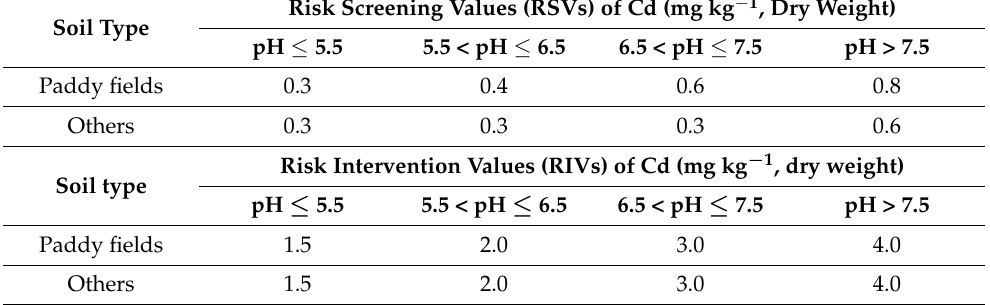
Table 1. The Risk Screening Values (RSVs) and the Risk Intervention Values (RIVs) of Cd for soil contamination of agricultural